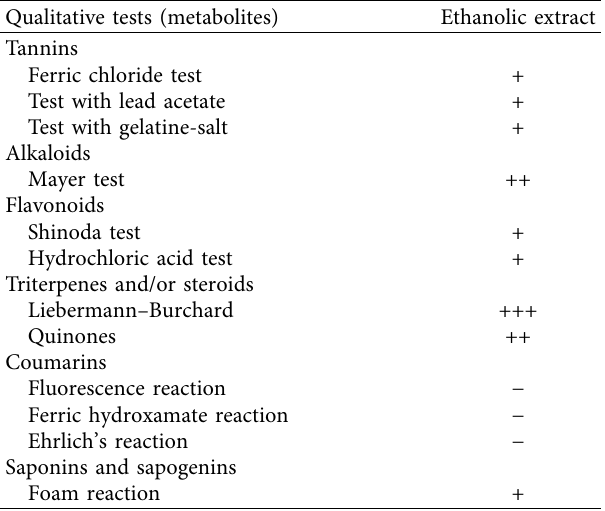
Table 2: Results of physicochemical analysis of extract from the bark of M. americana L.